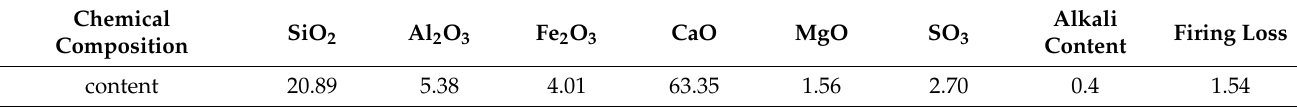
Table 2. Chemical composition of Portland cement.